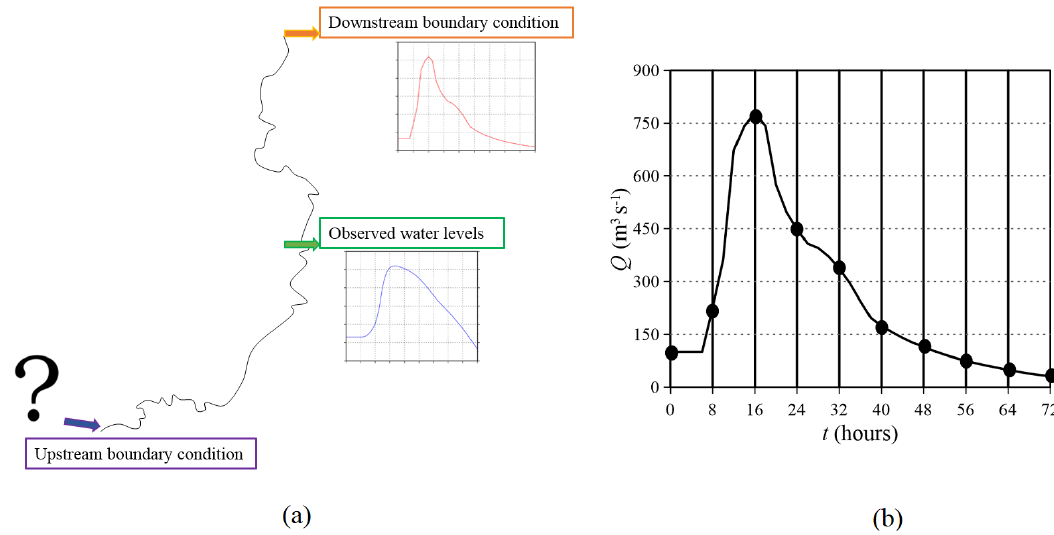
Figure 1. Definition of the reverse flood routing problem (a) and of the unknown parameters (b)